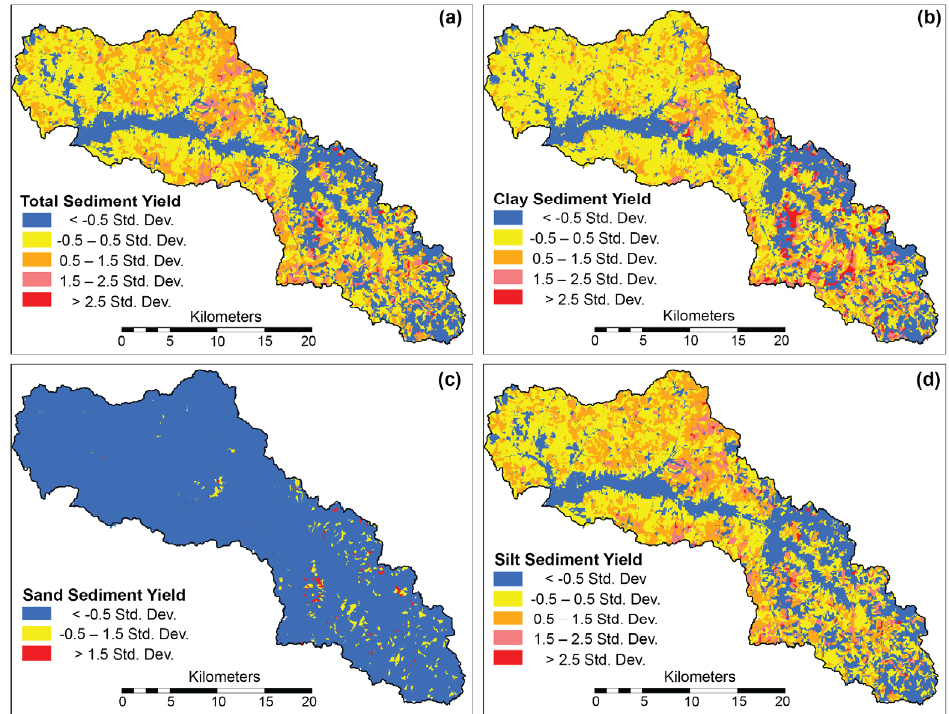
Figure 9. Spatial distribution of sediment yield for different particles sizes: ( a ) clay, ( b ) sand, ( c ) silt, and ( d ) total sediment, estimated using the AnnAGNPS model to describe existing conditions (baseline condition simulation). Graph depicts standardized approach in which values are expressed as deviations from the mean value of all 12,573 sub-catchments.